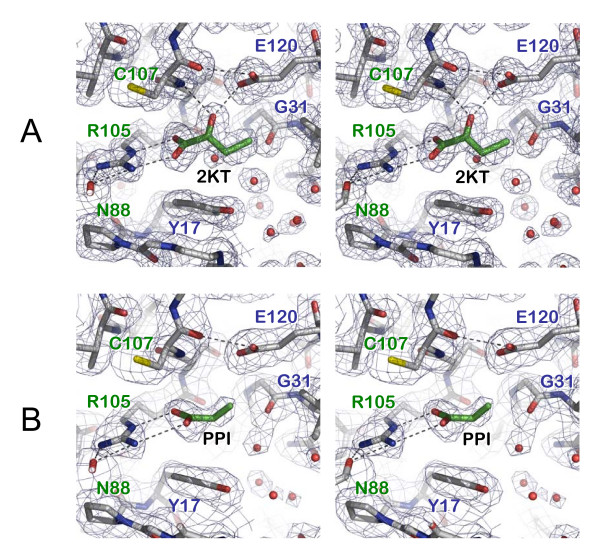
The ligand-binding pocket of TdcF in the ketobutyrate-bound and propionate-bound states. Stereoviews, prepared as for Figure 3, showing TdcF binding pockets in the following states: (A) with 2-ketobutyrate bound (1.6 Å resolution); (B) with propionate bound (2.45 Å resolution).